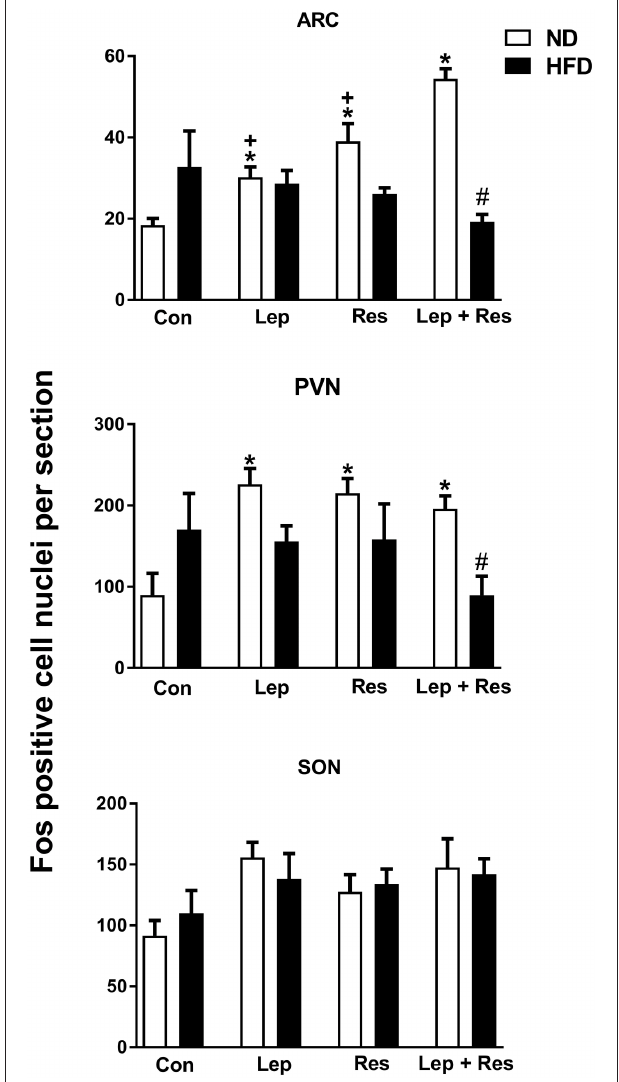
FIGURE 2 | Numbers of Fos-positive cell nuclei counted unilaterally per section in the supraoptic nucleus (SON), arcuate nucleus (ARC) and paraventricular nucleus (PVN) from rats fed a normal chow (ND) and a high fat diet (HFD). Rats were administered intracerebroventricular saline (control, n = 6 ND, n = 4 HFD; 5 µ l), leptin ( n = 5 ND, n = 5 HFD; 7 µ g in 5 µ l), resistin ( n = 4 ND, n = 4 HFD; 7 µ g in 5 µ l) or leptin combined with resistin ( n = 5 ND, n = 6 HFD). In the paraventricular nucleus (PVN) for saline ( n = 4 ND) and leptin ( n = 4 ND) due to technical issues. * 0.0001 < p < 0.005 compared with control in the ARC; * 0.005 < p < 0.01 compared with control in the PVN; # P < 0.0001 and # P < 0.01 HFD compared to ND in the ARC and PVN respectively; + 0.0001 < p < 0.005 compared with leptin +